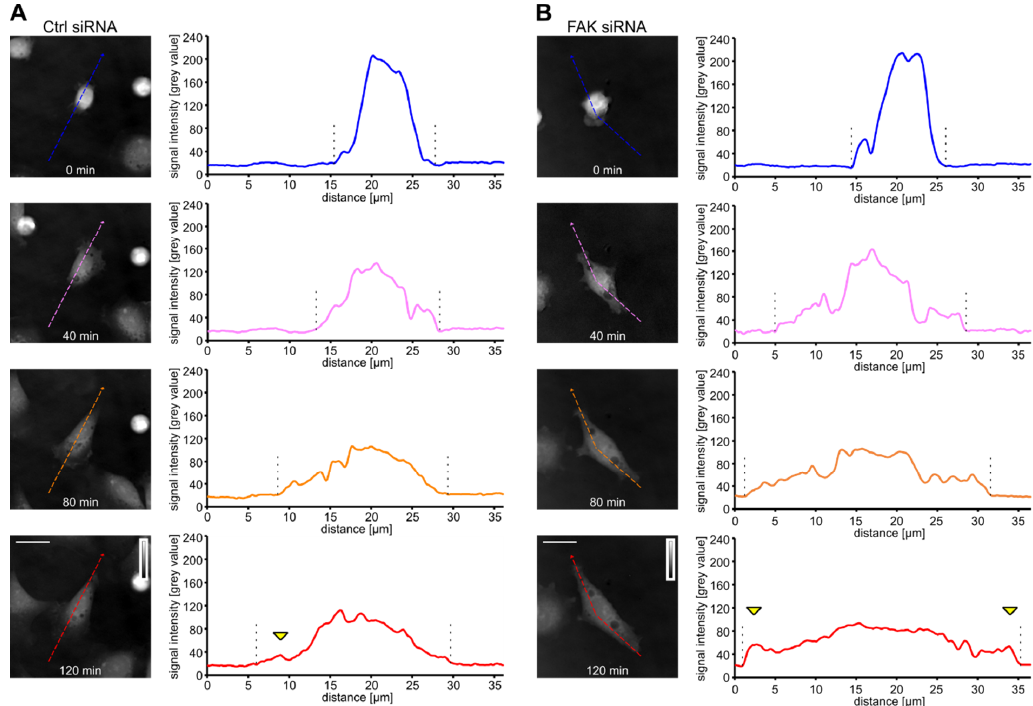
Figure 5. Dry mass distribution changes in spreading control and FAK-depleted cells. Grayscale quantitative phase images of control ( A ) or FAK-depleted ( B ) cells at indicated time points of cell spreading are presented (insets represent the signal intensity scale). The graphs show the distribution of signal intensities (i.e., cell dry mass) of corresponding sections. Cell borders are indicated by dashed lines. The increase in dry mass at a leading edge is indicated by the yellow arrowheads. Scale bar 10 μm.